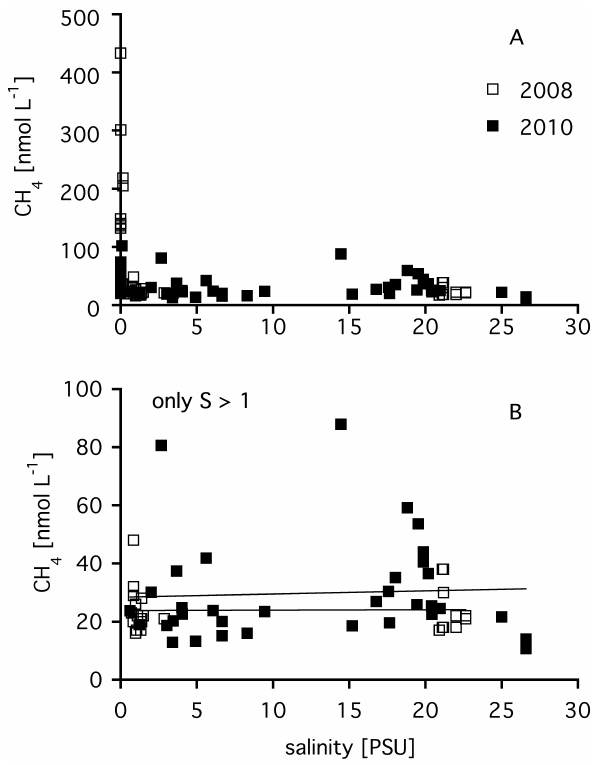
Fig. 8. Methane concentrations versus salinity for 2008 (open squares) and 2010 (closed squares). (A) all samples, (B) only sam- ples with a salinity of >